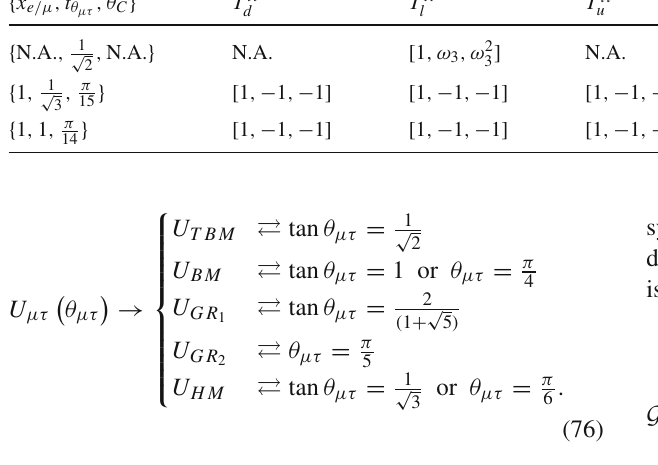
Table 4 The scan results from [32] that we will use to reconstruct models in Sects. 4.1 and 4.2. Note that we have relabeled D 30 → D 15 from [32] in order to reflect the conventions of [72] Finite groups, RFS, and mixing predictions { x , t θ ,θ e /μ C μτ